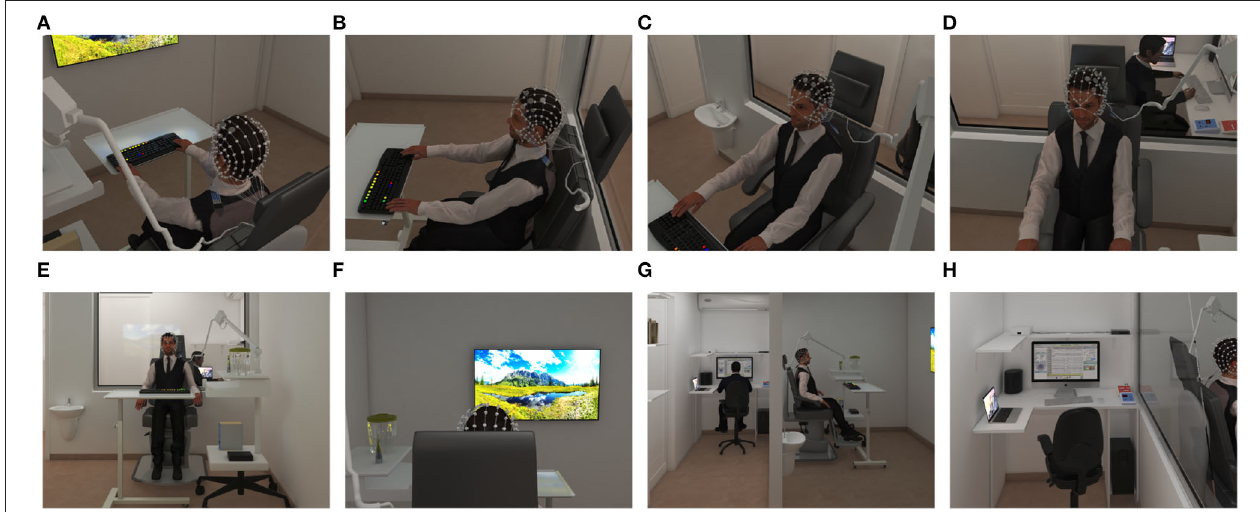
FIGURE 3 | Clinical space and setup 3-Dimensional simulation for educational approach Exam Room; selected rendered-picture from Panoramic View with Camera at 200 cm Attitude: (A) 0 ◦ degree angle (B) 30 ◦ degree angle (C) 60 ◦ degree angle (D) 90 ◦ degree angle. (E) The perspective of the exam room was showed from the LCD’s top. Control Room; selected rendered-picture from Panoramic View with Camera at 200 cm Attitude: (F) Exam room view was simulated from the clinician’s perspective. (G) The perspective of both exam and control rooms. (H) Overview of the control room and setup.